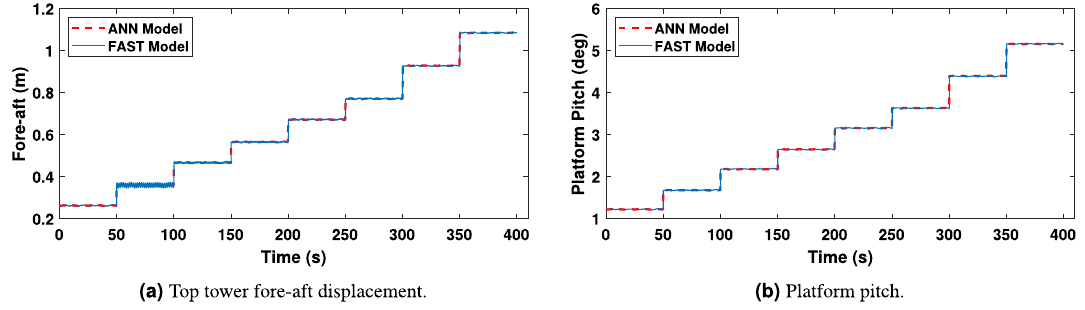
Figure 19. Top tower fore-aft displacement and platform pitch in irregular wave conditions.